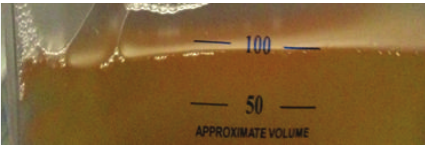
Figure 4: “Gold paint effusion” of